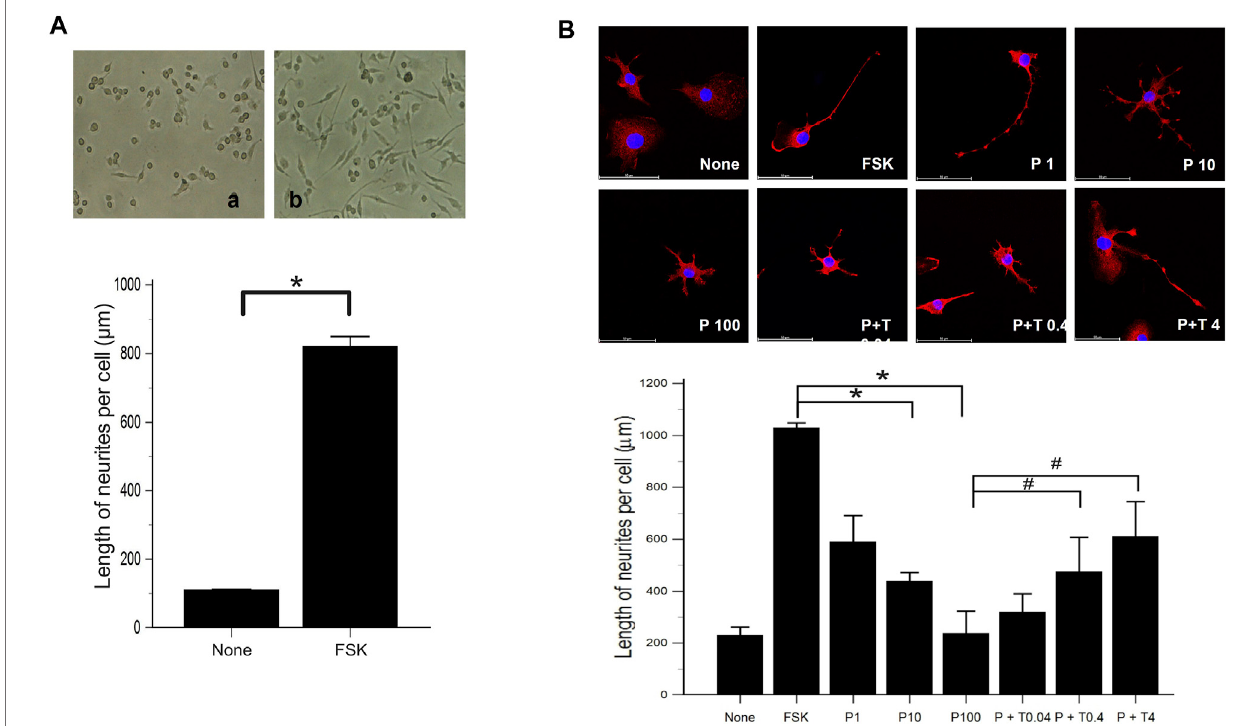
FIGURE 1 | Morphological differentiation of 50B11 cells (A) Low magni fi cation images illustrate the high ef fi ciency of morphological differentiation using FSK. Micrographs showing 50B11 cells cultured without mitogenic agents (no treatment) and the presence of 75 µM FSK ( n = 5 per group). (B) By immuno fl uorescence, the cells werestained for β III-tubulin (red), and the cell nuclei were counterstained with DAPI (blue). Cells were cultured in the absence ofmitogenicagents and the presence of 75 µM forskolin. Differentiated cells were treated with 1, 10, and 100 ng/ml PAC and 100 ng/ml PAC with 0.04, 0.4, and 4 ng/ml TMI-1 (Scale bar = 50 µm). Analysisofneuritelengthin50B11cellsshoweddifferencesinundifferentiatedcells ’ morphologicalcharacteristicscomparedtodifferentiatedcells.Datawerepresented as the median and interquartile range (IQR) and analyzed using the Mann-Whitney U test or Kruskal-Wallis test followed by the Conover test ( n = 4 per group). * p < 0.05 compared to the FSK; # p < 0.05 compared to the